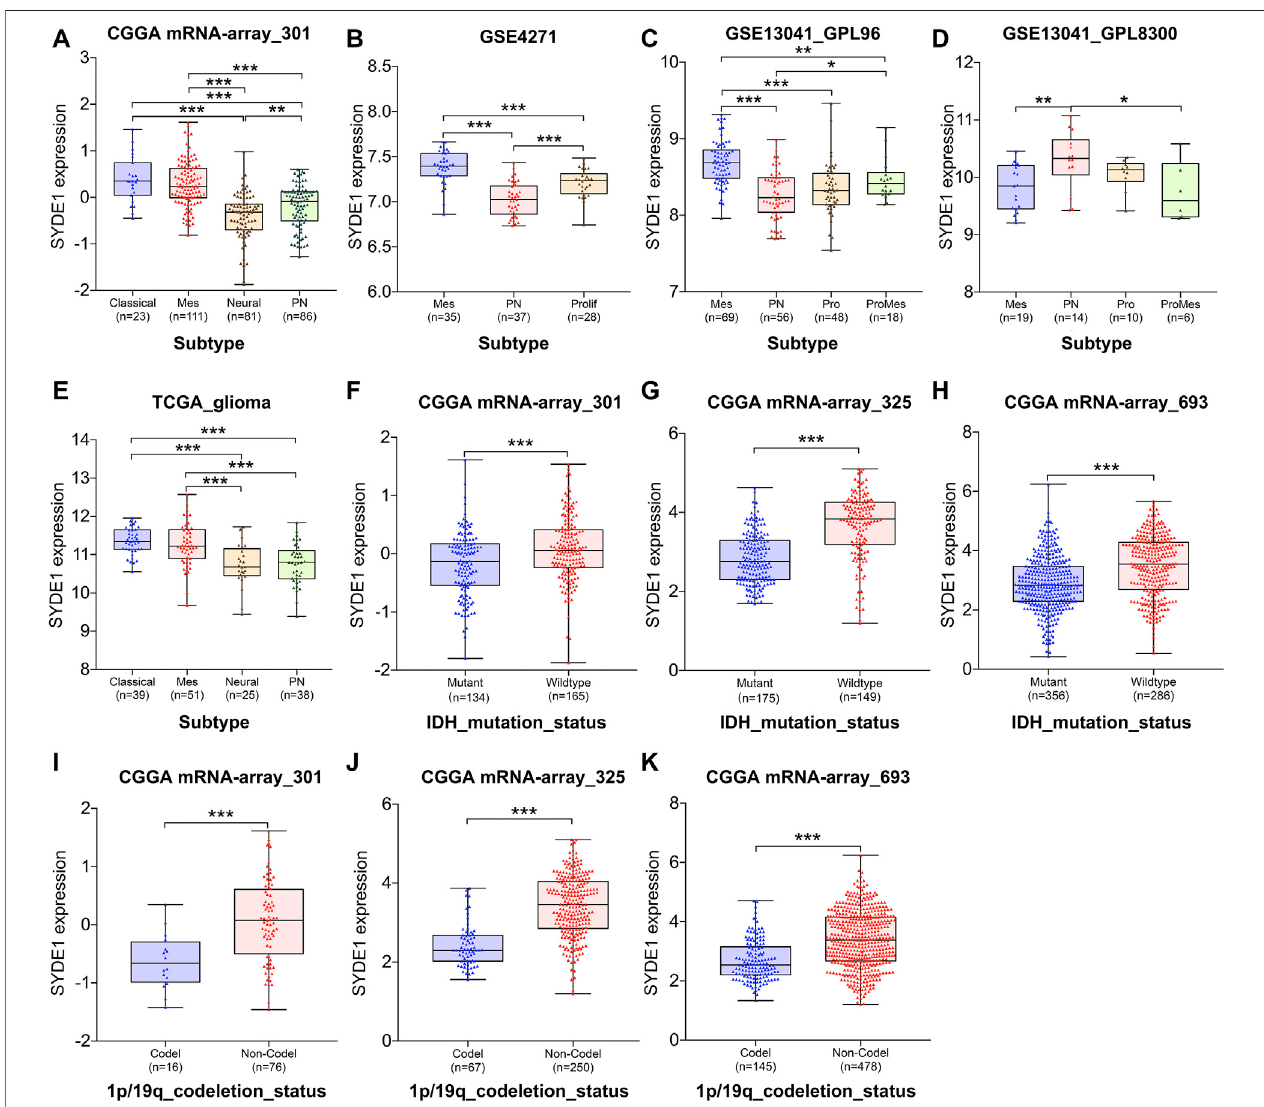
FIGURE 6 | The association between SYDE1 expression and glioma subtypes, IDH mutation or 1p/19q co-deletion. (A – E) The association between SYDE1 expression and glioma subtypes. (F – H) The association between SYDE1 expression and IDH mutation. (I – K) The association between SYDE1 expression and 1p/19q co-deletion. *, p.value < 0.05; **, p.value < 0.01; ***, p.value <